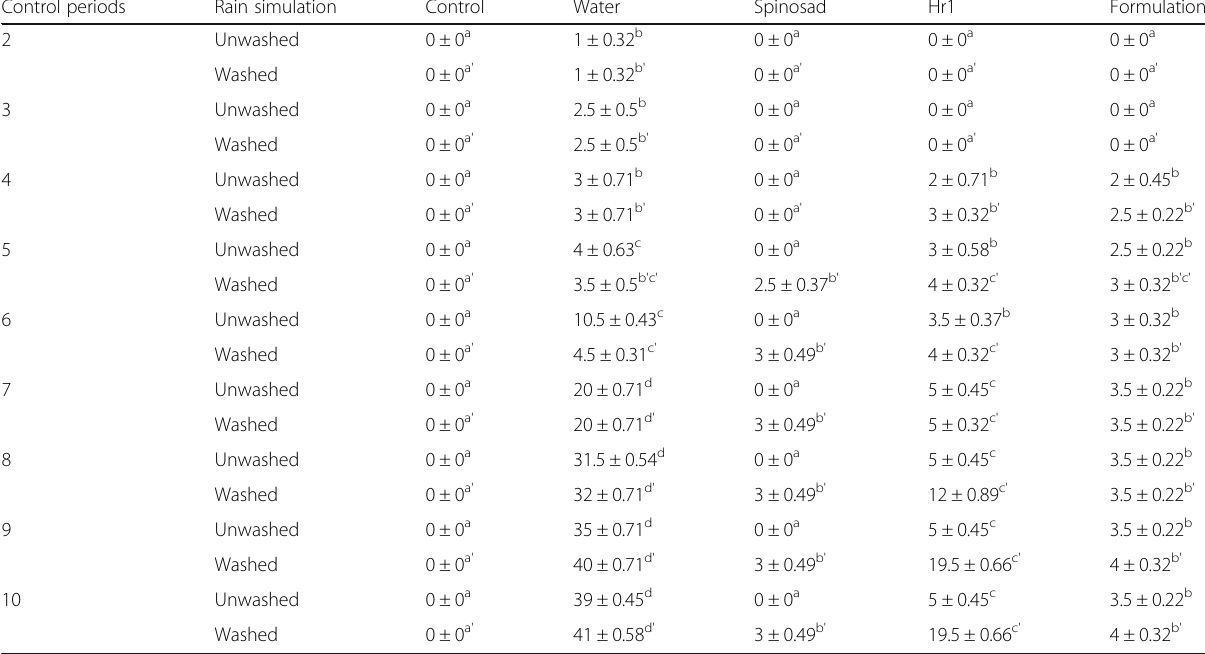
Table 3 Mean percentage of infested tomato fruits by Helicoverpa armigera larvae during greenhouse experiments. Values represent mean per cent attacked tomato fruits ± standard error ( n = 5) Control